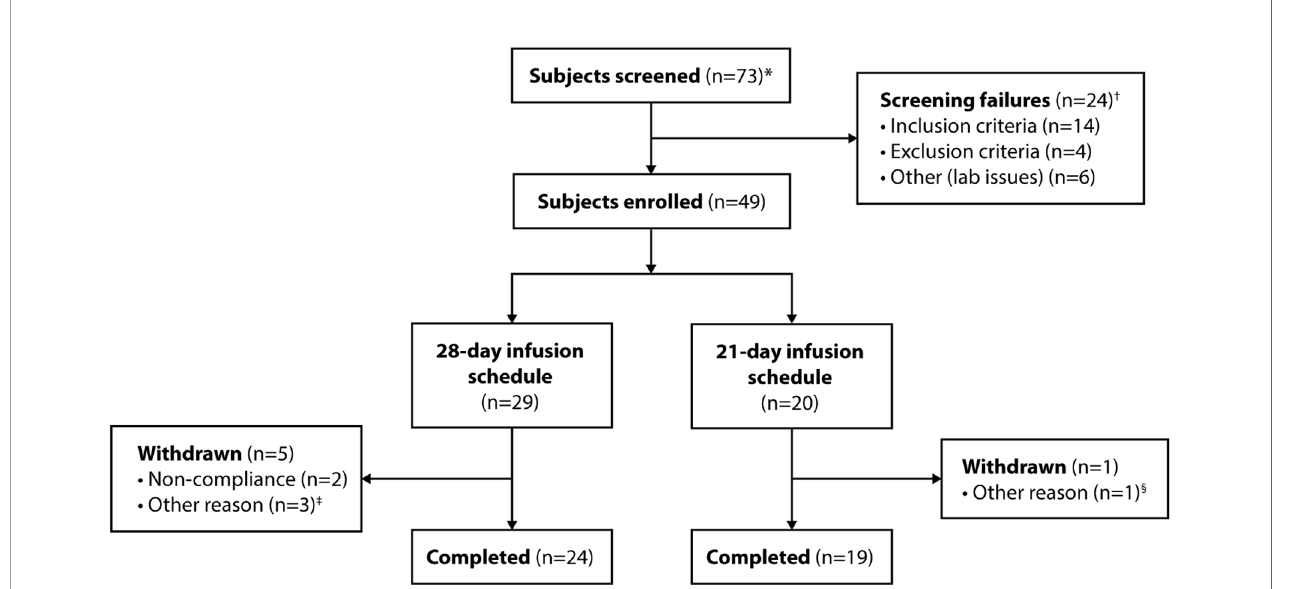
FIGURE 1 | Subject disposition. *Includes subjects who were re-screened. † Six of the 24 screen failures (5 subjects) were subsequently re-screened and enrolled in the study. ‡ Withdrawal of consent (n = 2); withdrawal by sponsor due to melanoma diagnosis (n = 1). § Inability to obtain IV